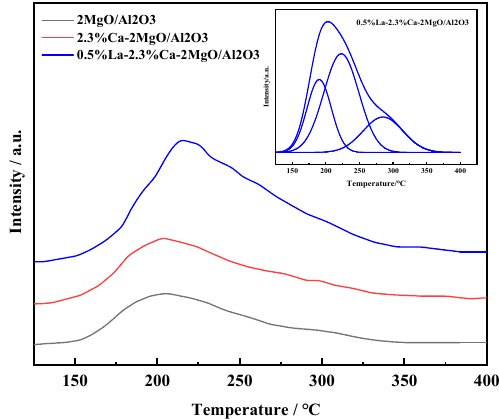
Figure 4. CO 2 ‐ TPD profiles of composite oxides.